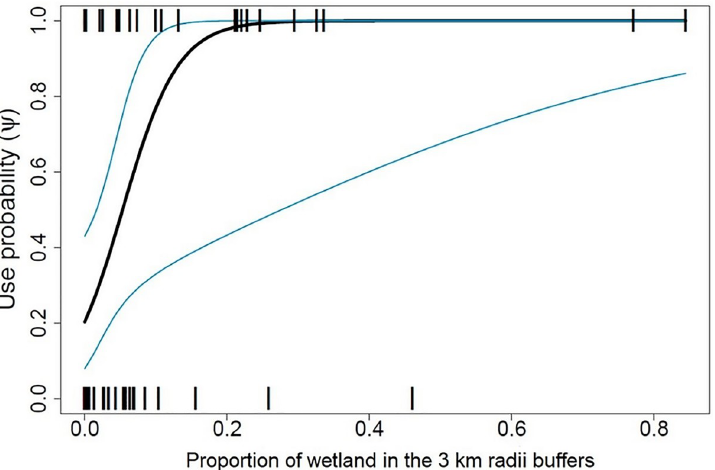
Fig 3. Jaguar habitat use ( ± 90% CI) as a function of wetland coverage. Displayed at camera trap sites surrounded by 3 km buffers in the middle Magdalena River valley, Colombia.